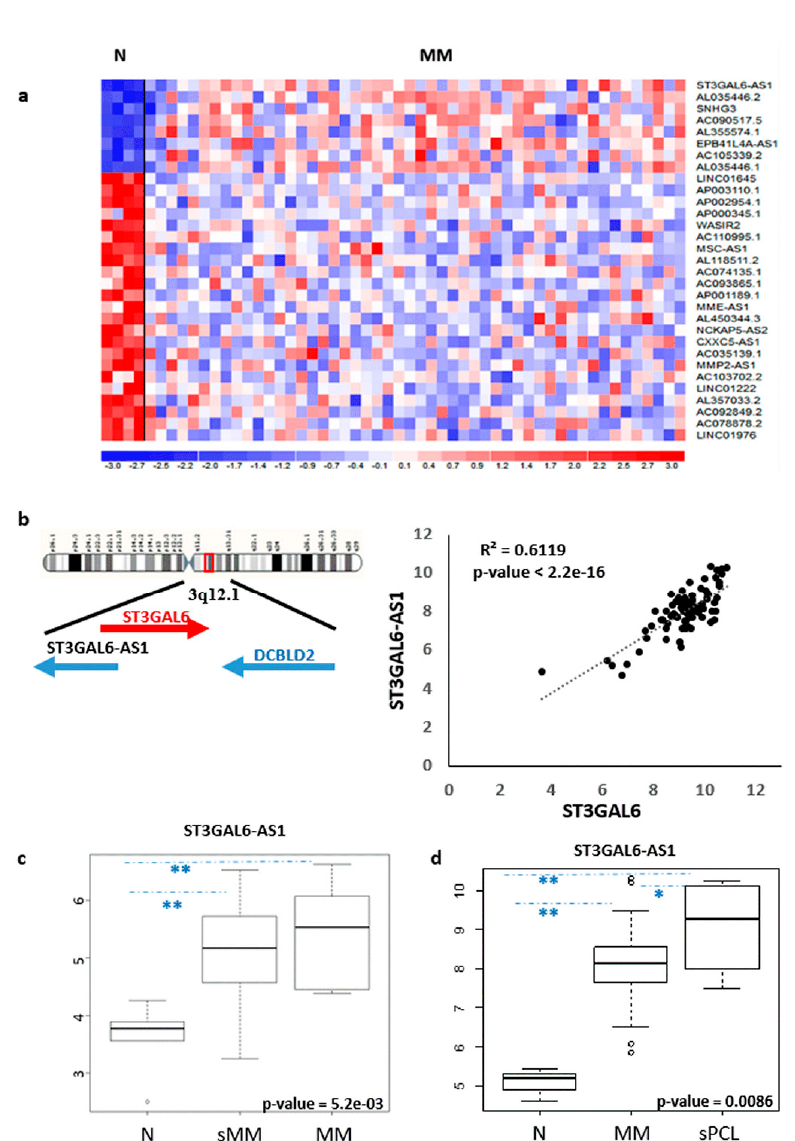
Figure 1. Identification of lncRNAs deregulated in MM patients. ( a ) Heatmap of the 31 differentially expressed lncRNAs in 50 MM patients as compared to four normal bone marrow PC controls (patients in columns, lncRNAs in rows). The color scale bar represents the relative lncRNA expression changes normalized by the standard deviation. ( b ) Genomic context of ST3GAL6-AS1; Pearson’s correlation analysis of ST3GAL6 (x-axis) and ST3GAL6-AS1 (y-axis) expression levels. Correlation coefficient R and significant p-value are reported. ( c ) Boxplot of ST3GAL6-AS1 expression in five normal controls, 21 sMM and 10 MM samples (** p < 0.01). ( d ) Boxplot of ST3GAL6-AS1 expression in four normal controls, 50 MM, and six sPCL samples (* p < 0.05, ** p < 0.01).